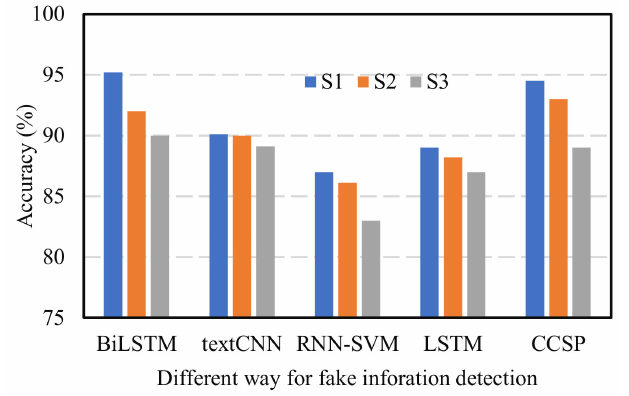
Figure 4. Fake information detection